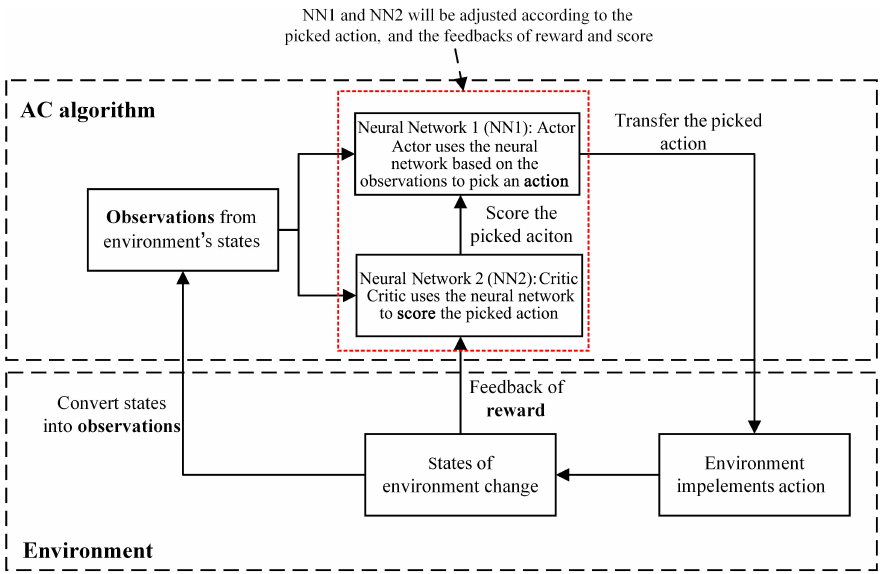
Fig. 6 Function of AC